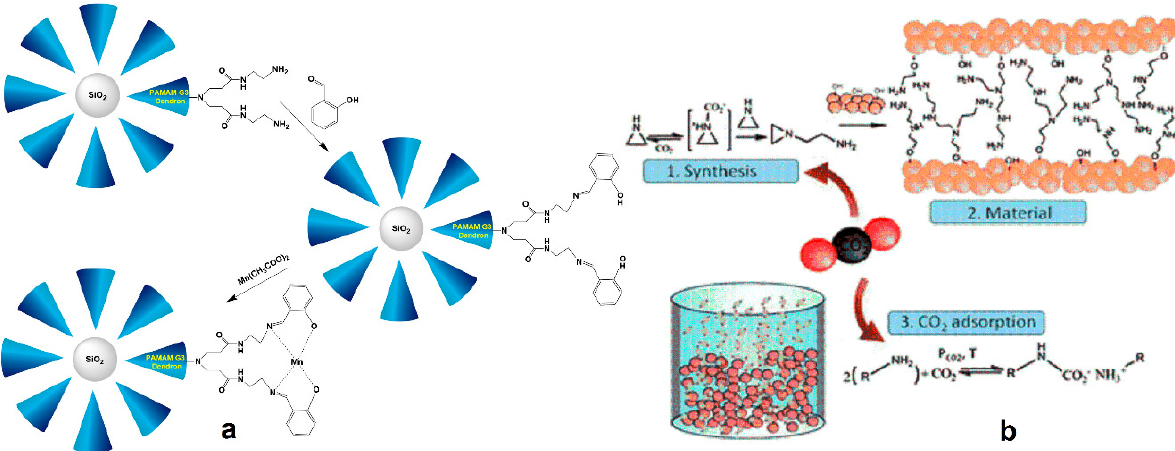
Figure 15. ( a ) Procedure for assembling Silica-PAMAM Dendron-Manganese Composite Catalysts. ( b ) Schematic represen- tation of PEI dendron growth onto silica using CO 2 , and the mechanism of posterior CO 2 adsorption (intended application) ( Reproduced with permission from [127]; Copyright Royal Society of Chemistry, 2013).